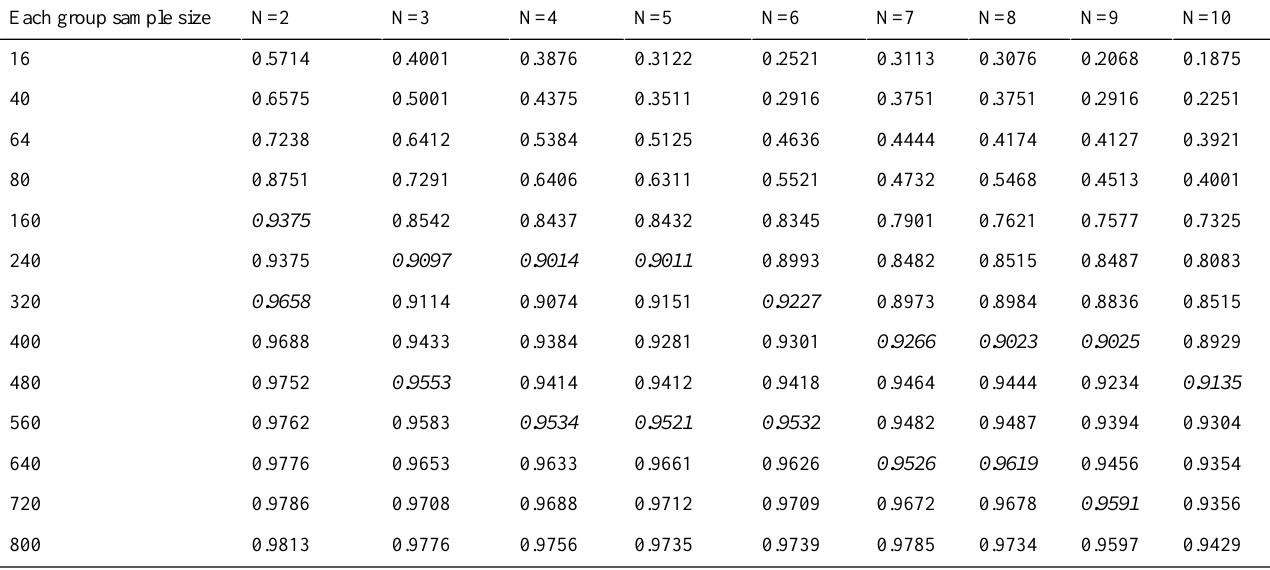
Table 7. Average accuracy analysis grouped by sample size of each group and number of syndrome pattern type.